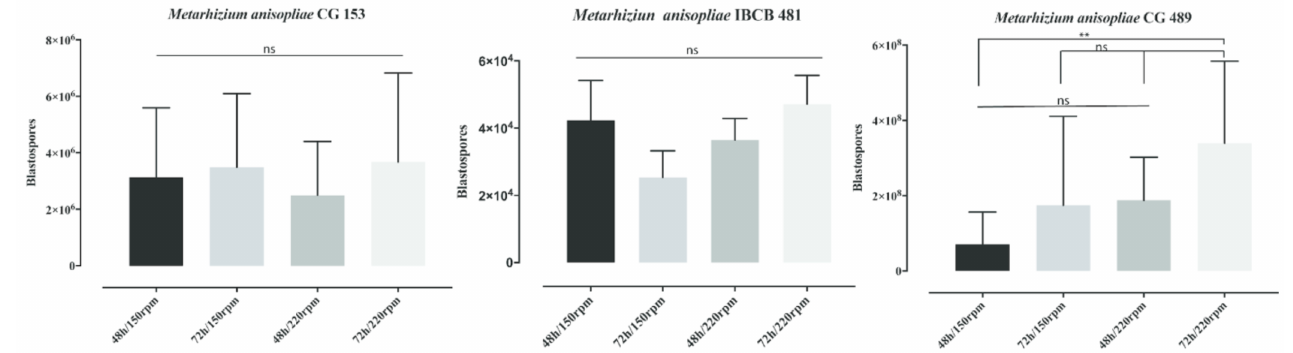
Figure 1. The production of blastospores of three different Metarhizium anisopliae s.l strains under different shaker rotations and times. Significance levels were calculated, and their strength was displayed with the symbol (** p < 0.001; ns = not